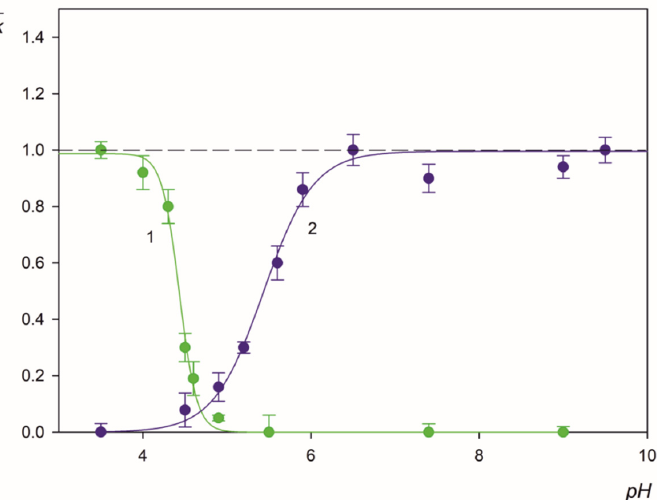
Figure 9. Normalized rate of LSfi particle deposition at mica and mica/PLL as a function of pH. The solid line 1 represents a fit of experimental data for mica/PLL deposition and solid line 2 is a fit of experimental data obtained for the mica/PLL substrate.